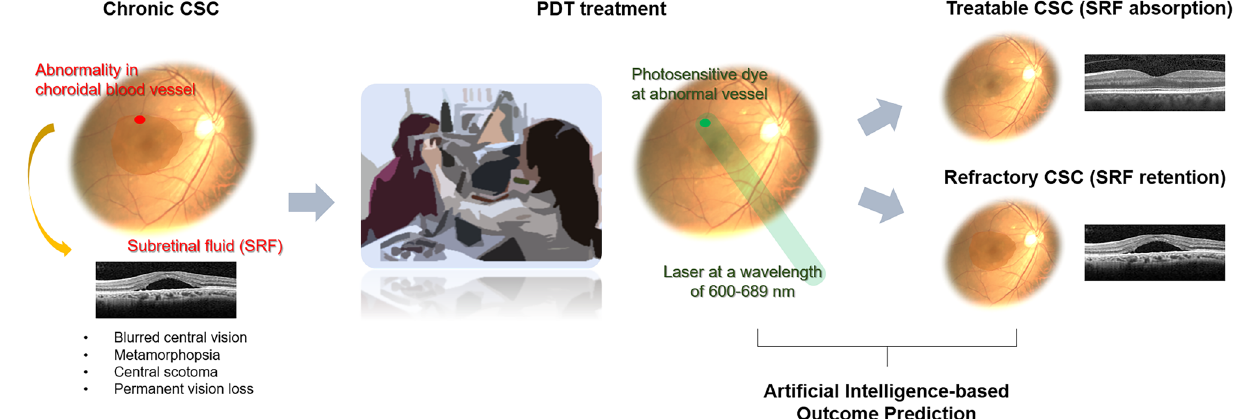
Figure 1. A schematic diagram of the process of photodynamic laser therapy (PDT) on central serous chorioretinopathy (CSC) and the purpose of this